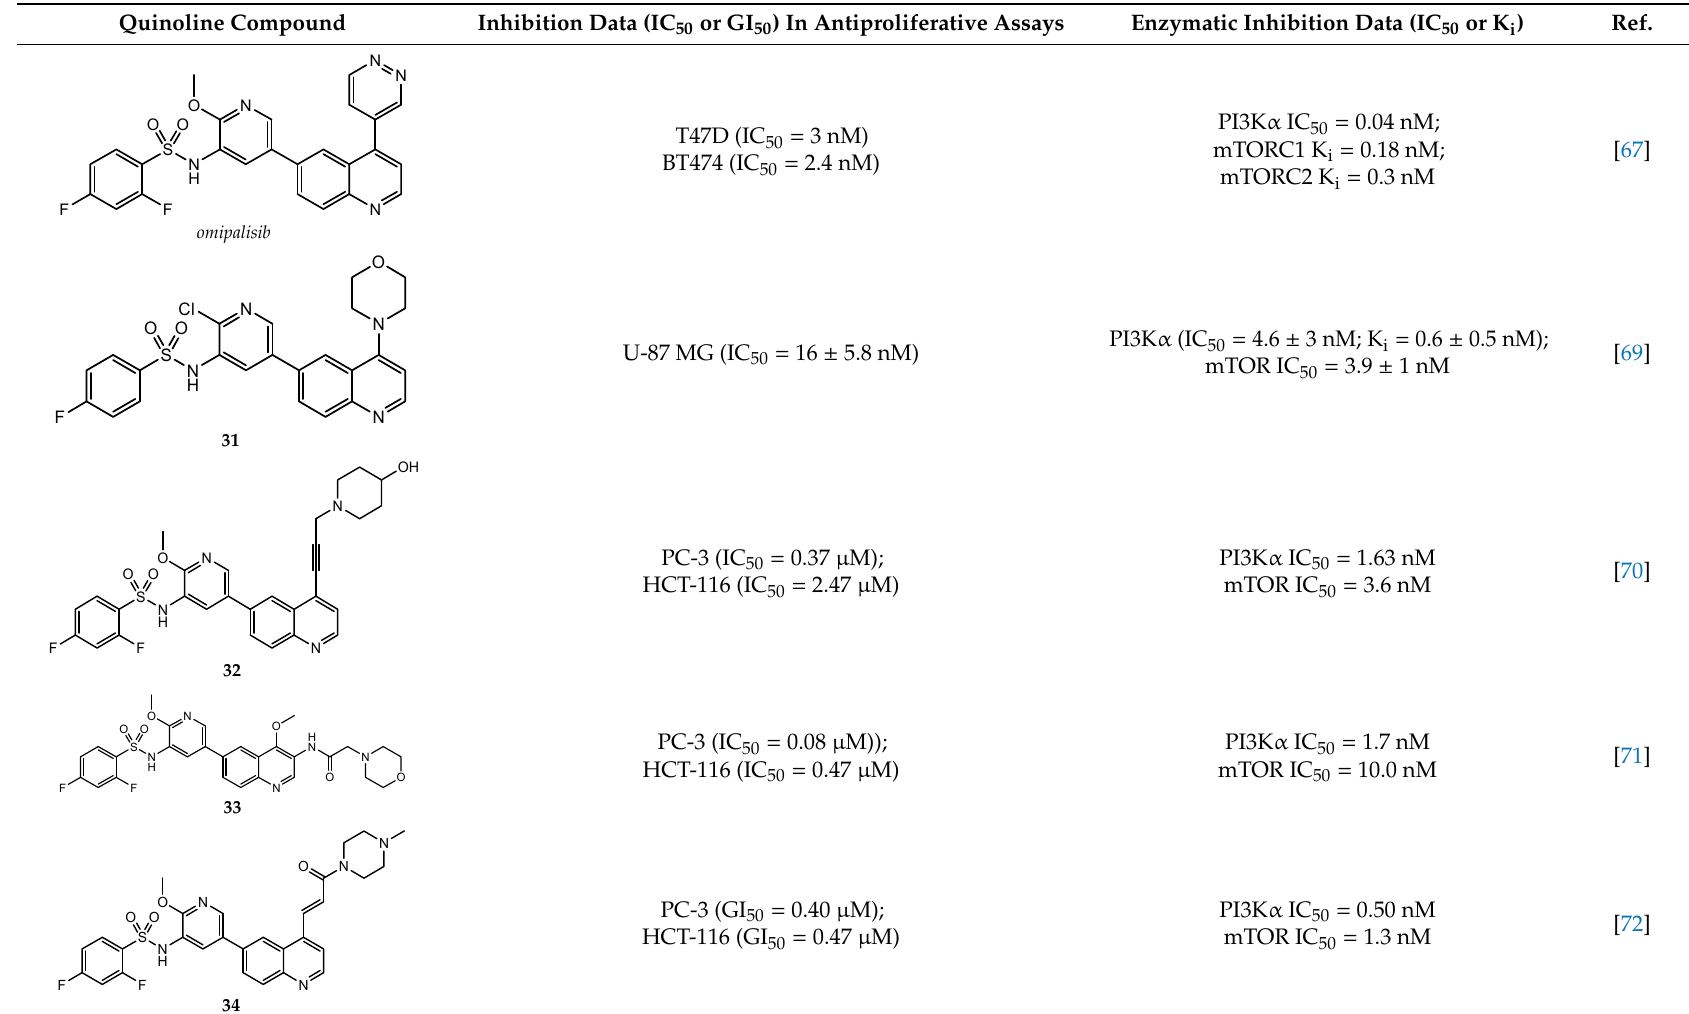
Table 2. Omipalisib and analogues 31 – 34 selective active on PI3K α and mTOR.